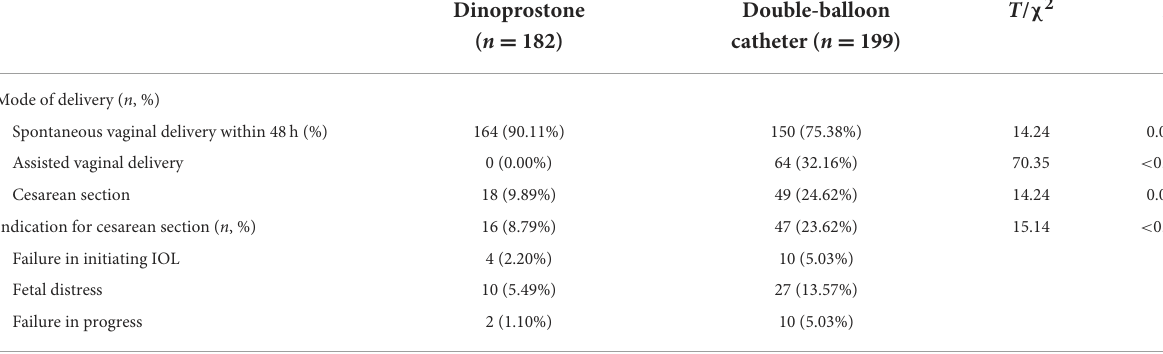
TABLE 3 Comparison of intrapartum outcomes (primary and secondary outcomes) in two groups.